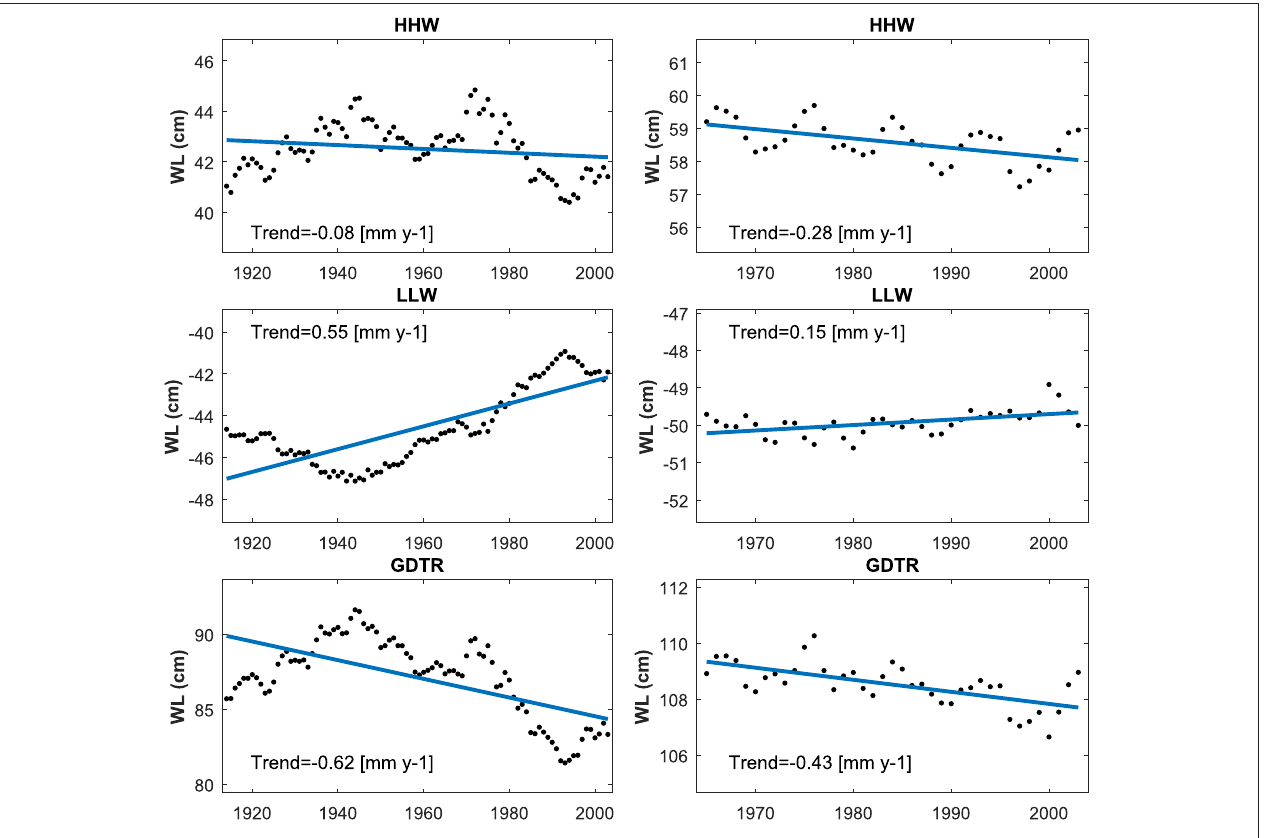
FIGURE 4 | Linear trends of Annual HHW, LLW, and GDTR of Buenos Aires (Left) and Mar del Plata (Right) .